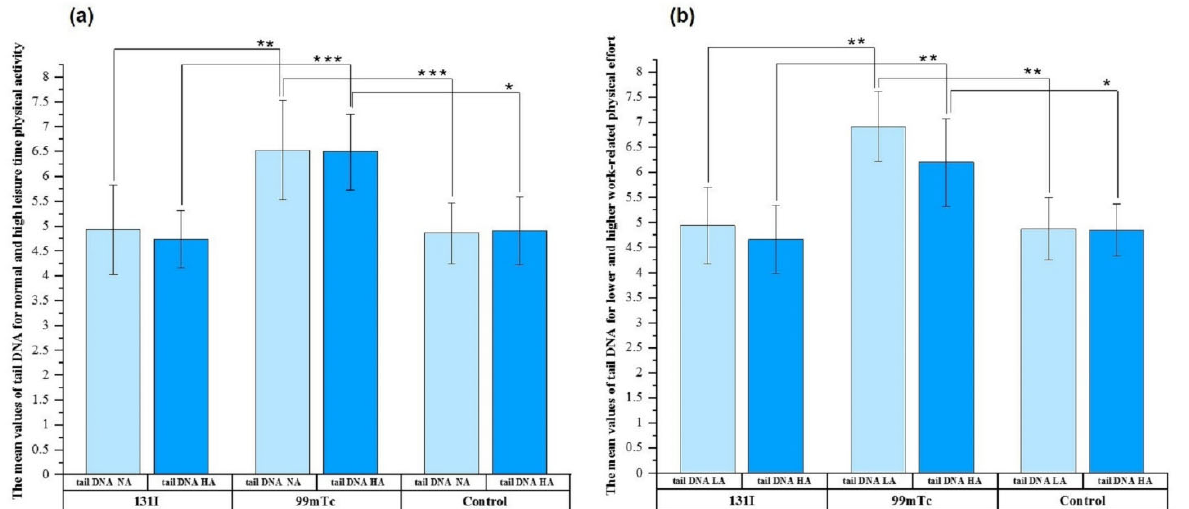
Figure 2. Mean values of tail DNA for normal (NA) and high (HA) leisure time physical activity ( a ), and low (LA) and high (HA) work-related physical effort ( b ) in the three studied groups. The error and low (LA) and high (HA) work ‐ related physical effort ( b ) in the three studied groups. The error bars represent the standard deviation. * p ≤ 0.01; ** p ≤ 0.05; *** p ≤ bars represent the standard deviation. * p ≤ 0.01; ** p ≤ 0.05; *** p ≤ 0.001.